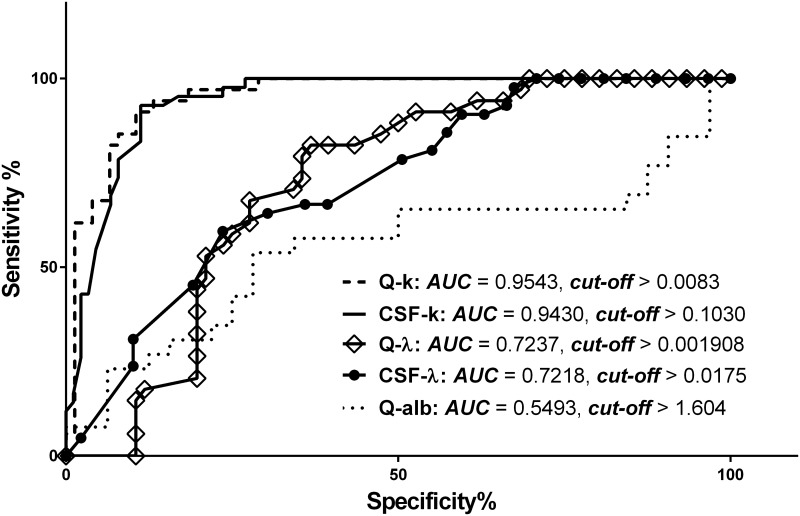
Receiver operator curve (ROC) characteristic analysis between CIS-MS and control group.AUC: area under curve; CSF k-FLC: concentration of kappa free light chains in cerebrospinal fluid (CSF); CSF λ-FLC: concentration of lambda free light chains in CSF; Q-k: CSF/serum quotient of concentrations of kappa free light chains; Q-λ: CSF/serum quotient of concentrations of lambda free light chains.